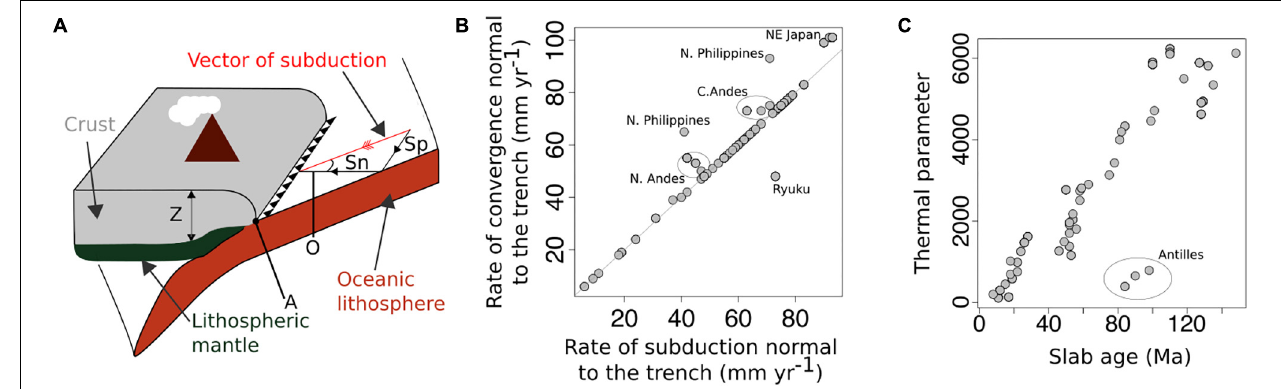
FIGURE 4 | (A) Schematic for the exchangeable subduction zone, with the crustal thickness (Z), age of the slab (A), convergence obliquity (O), normal (Sn) and parallel (Sp) components of subduction all labeled; (B) plot of the convergence rate (the sum of the velocities of the subducting plate and the trench/arc system) versus the subduction rate for the arc segments from Lallemand et al. (2005) used in our study. As can be seen in the figure, the rate of subduction is broadly the same as the rate of convergence. We have labeled regions that do not fall on the 1:1 line between convergence rate and subduction rate; (C) A plot of the thermal parameter (Eq. 1) versus the age of the slab (A). At the global scale, variation in the thermal parameter is dominantly controlled by the age of the subducting slab. We label the Antilles, which is the only region whose thermal parameter is strongly controlled by the vertical rate of subduction.